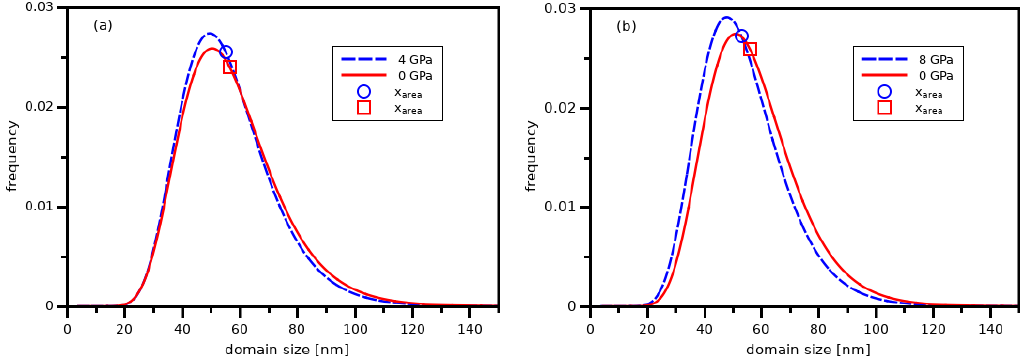
Figure 3. The size distribution of the coherently scattering domains resulting from the convolutional multiple whole profile evaluation (CMWP) fit for copper after HPT deformation at 4 ( a ) and 8 GPa ( b ), respectively.“ p = 0 GPa” denotes the sample state after the pressure release